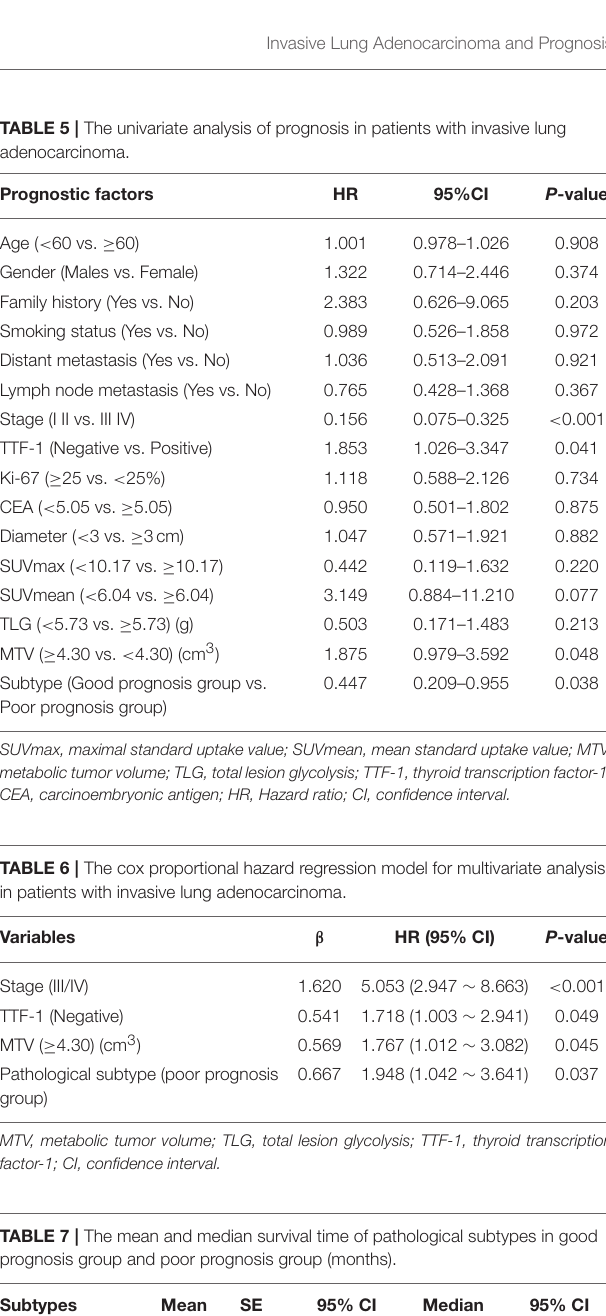
TABLE 7 | The mean and median survival time of pathological subtypes in good prognosis group and poor prognosis group (months).